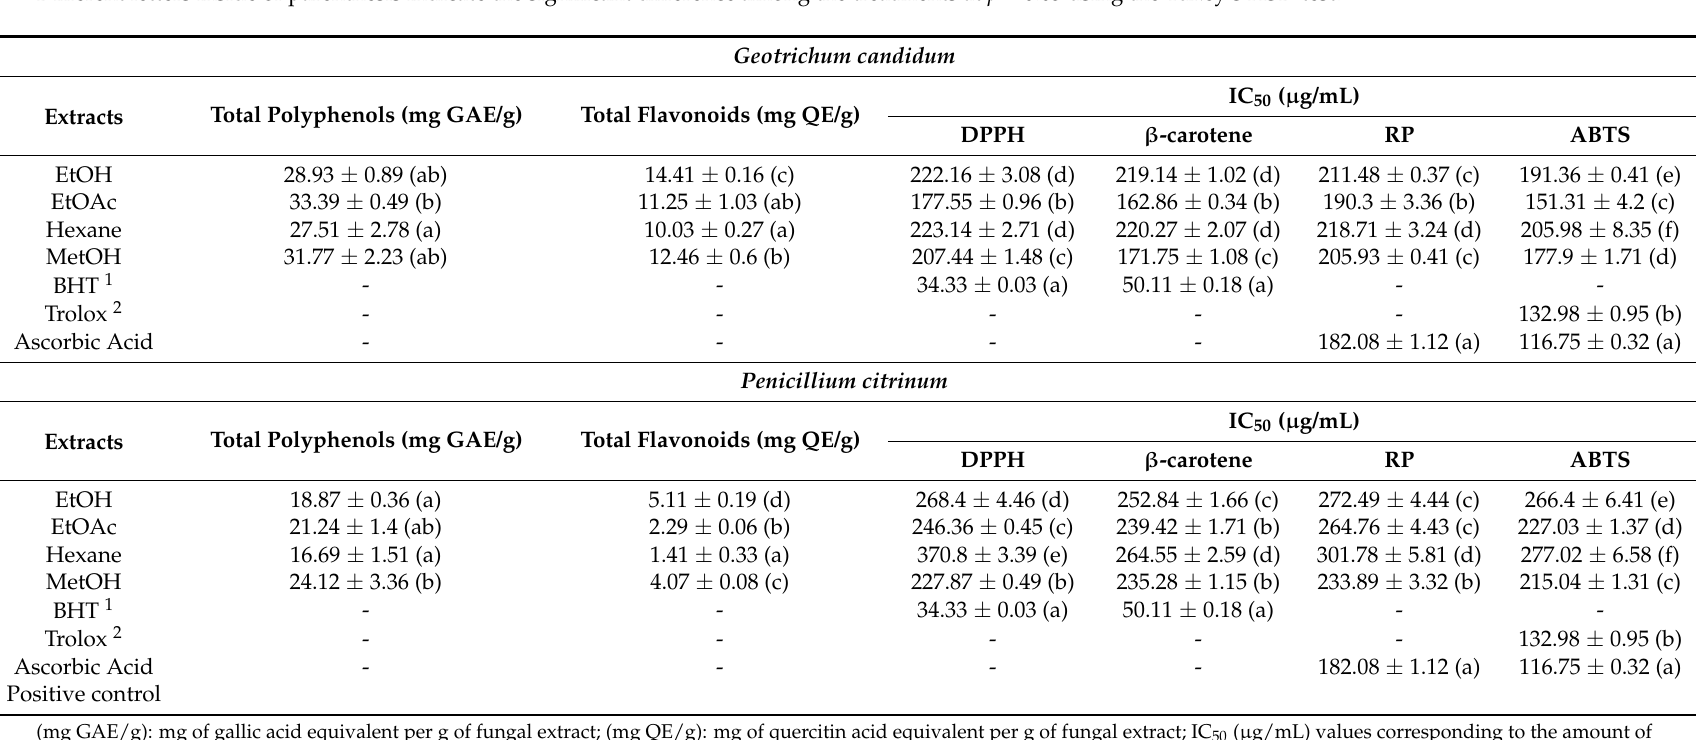
Table 2. Assessment of total polyphenol, total flavonoid content and antioxidant activity of Geotrichum and Penicillium extracts. Data presents mean ± standard error. Different letters inside of parenthesis indicate the significant difference among the treatments at p < 0.05 using the Tukey’s HSD